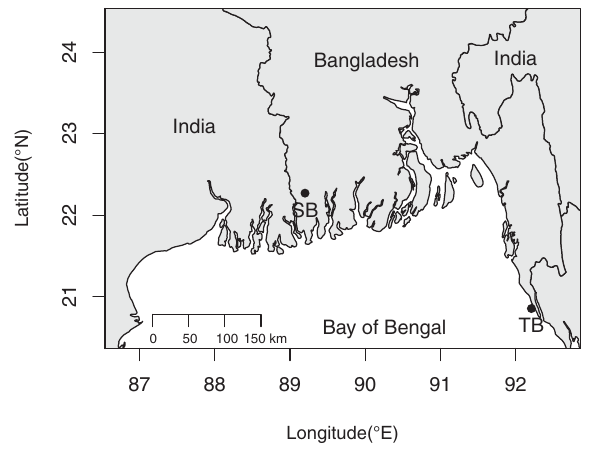
Fig. 1. Parapenaeopsis sculptilis sampling sites along the coastline of Bangladesh. Capital letters indicate sites: SB- Sundarban at Satkhira in Bangladesh and TB- Teknaf Beach at Cox ’ s Bazar in